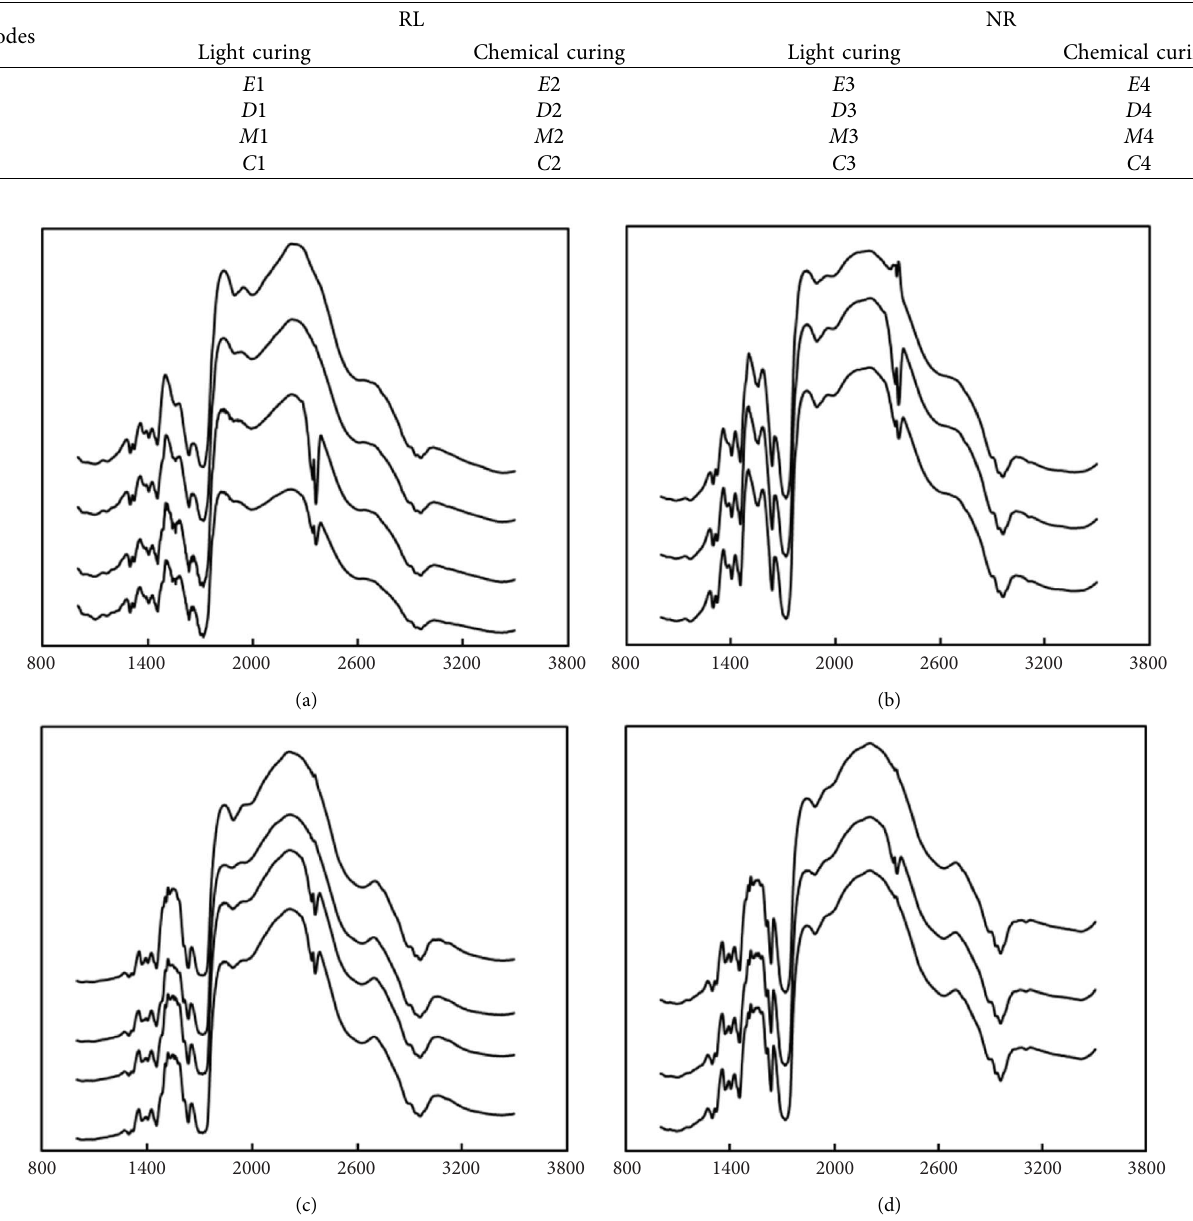
Figure 1: FT-IR spectra of cements. (a) Light-curing sample (RL): 1min after mixing, light curing, 30 min after mixing, and 60min after mixing (from top to bottom). (b) Chemical sample (RL): 1 min, 30min, and 60min after mixing (from top to bottom). (c) Light-curing sample (NR): 1min after mixing, light curing, 30 min after mixing, and 60min after mixing (from top to bottom). (d) Chemical sample (NR): 1min, 30min, and 60min after mixing (from top to bottom).